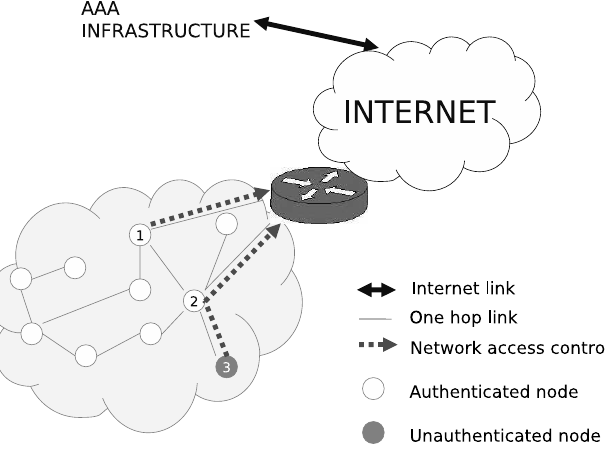
Figure 1. Network connectivity and access